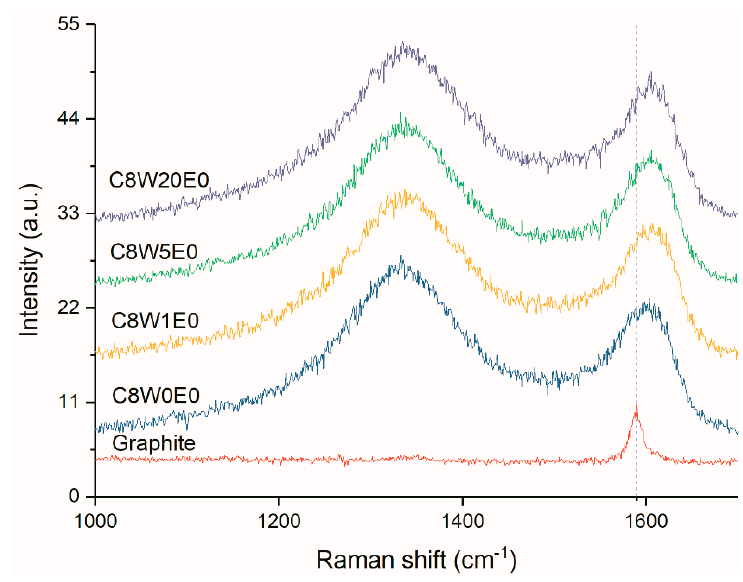
Figure 8. Raman curves of AGAs with different microwave processing times.